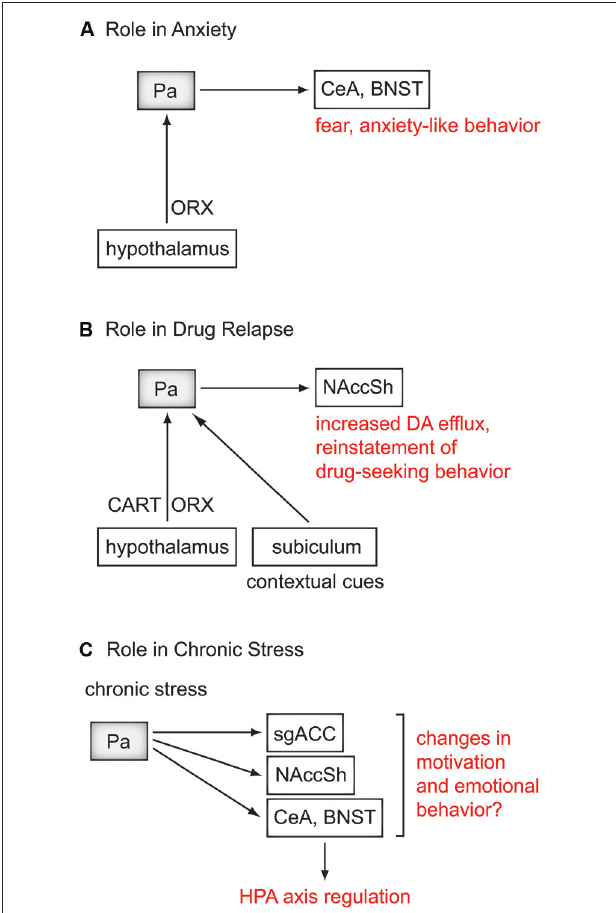
FIGURE 2 | Contributions of the Pa in psychiatric disorders. Rodent studies suggest a role for the Pa in anxiety, drug relapse, and regulating the effects of chronic stress. (A) Orexin (ORX) projections from the hypothalamus to the Pa regulate fear and anxiety-like behavior through the central nucleus of the amygdala (CeA), and bed nucleus of the stria terminalis (BNST). (B) In a pathway for drug relapse, ORX and cocaine- and amphetamine-related transcript (CART) from the hypothalamus, and contextual cues from the subiculum project to the Pa. In turn, the Pa regulates dopamine (DA) efflux in the nucleus accumbens shell (NAccSh) and drug-seeking behavior. (C) Via the CeA and BNST, the Pa has been shown to be an important regulator of the hypothalamic-pituitary-adrenal (HPA) axis during chronic stress. A few studies in rodent models of depression have shown involvement of the Pa, however its specific role in depressive-like behavior remains to be determined. The role of the Pa in regulating chronic stress may also influence (A) and (B) . There is likely significant overlap between the pathways for these disorders, which are highly comorbid, and are exacerbated by severe or chronic stress. MDD, major depressive disorder; sgACC, subgenual anterior cingulate